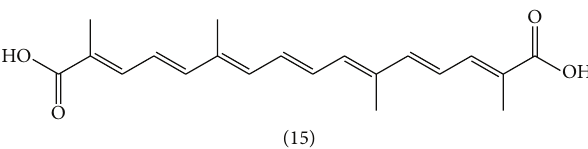
Figure 4: Chemical structure of carotenoid: (15) crocetin.